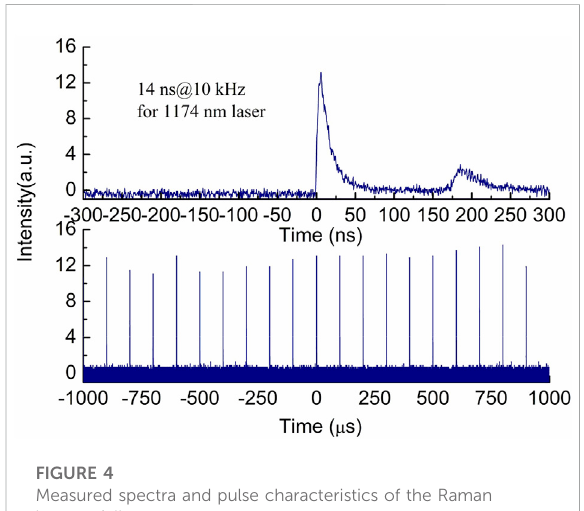
FIGURE 4 Measured spectra and pulse characteristics of the Raman laser at full output